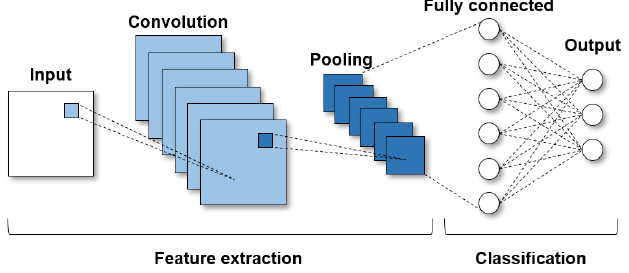
Figure 4. Basic CNN architecture.